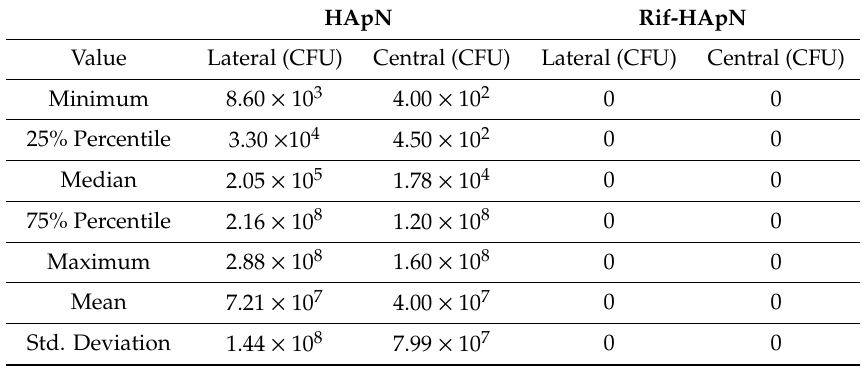
Table 2. Bacterial adhesion to the surface of the di ff erent implants. Quantification of bacterial adhesion to the implant surface via sonication. Results are described as the average bacterial load (CFU) yielded from the lateral and central fragments collected from the implants of the di ff erent study